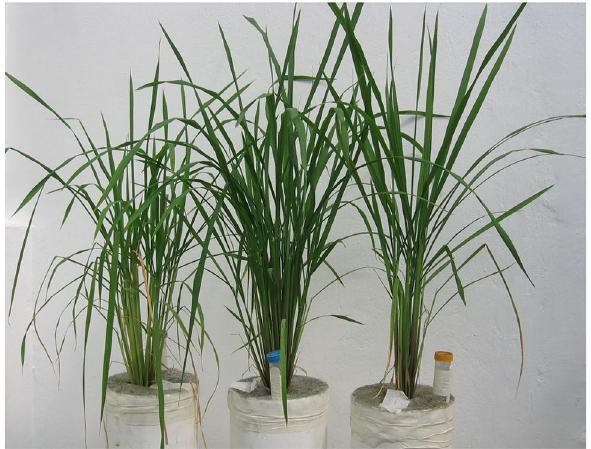
Figure 4. Samples of the rice genotypes IR64 (left), Apo (right), and their F1 hybrid (center) were grown in large pots and were exposed to both non- and water-stress